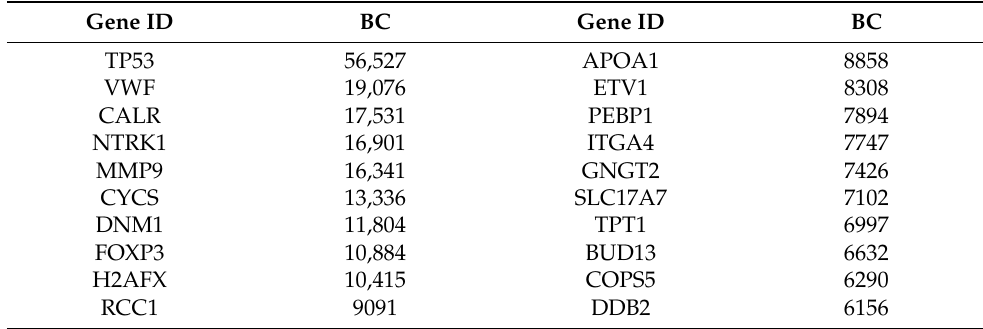
Table 2. Communication hubs identified in network of transcripts involved in predicted synergism between HDACi and sphingolipid signaling